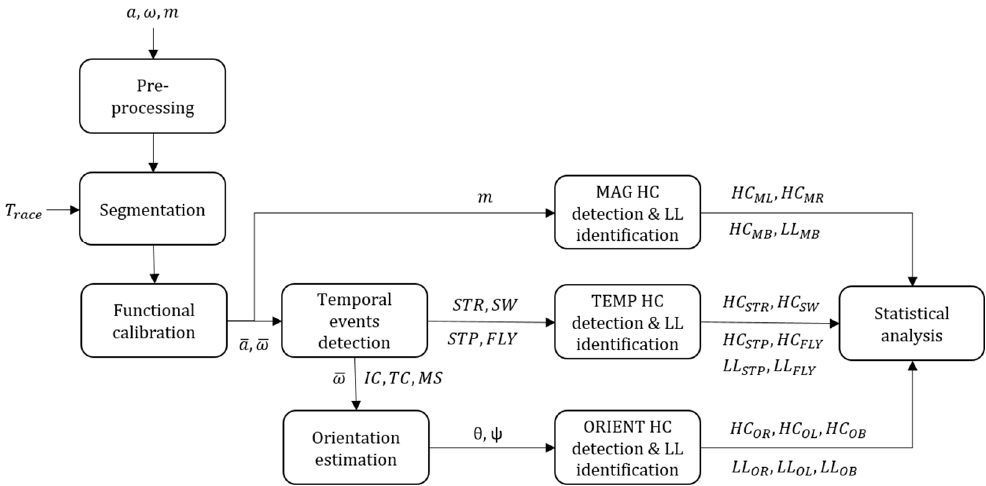
Figure 3. Flow chart of the proposed hurdle clearance detection method. We defined the inputs as follows: a the accelerometer data, ω the gyroscope data, m the magnetometer data, T race the official race duration, θ the pitch angle, and ψ the yaw angle of the foot. Initial contact (IC), terminal contact (TC), mid-stance (MS), stride time (STR), swing phase duration (SW), step duration (STP), and flight phase duration (FLY) result from the temporal analysis. Hurdle clearance (HC) detection results are shown as HC XX and leading leg detection results as LL XX , where XX describes the detection method.